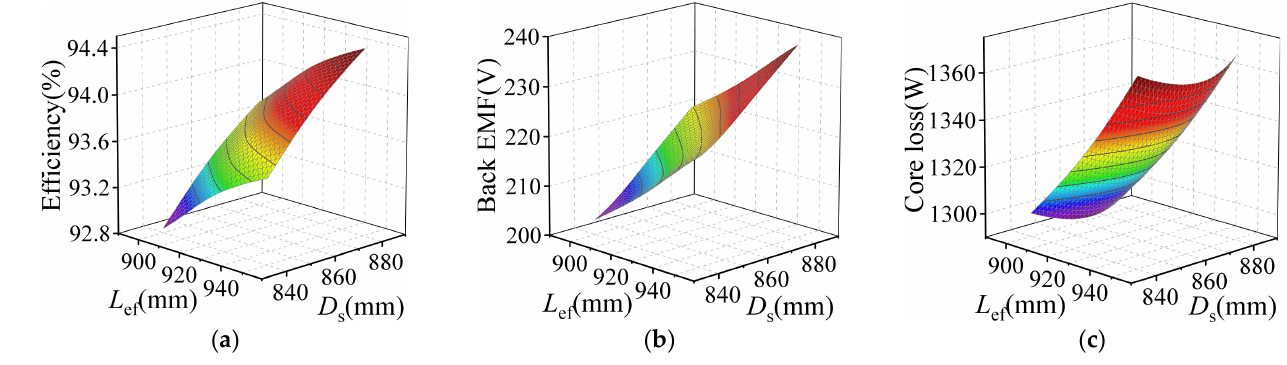
influence on the no ‐ load back EMF. As the air gap length increases, the no ‐ load back EMF